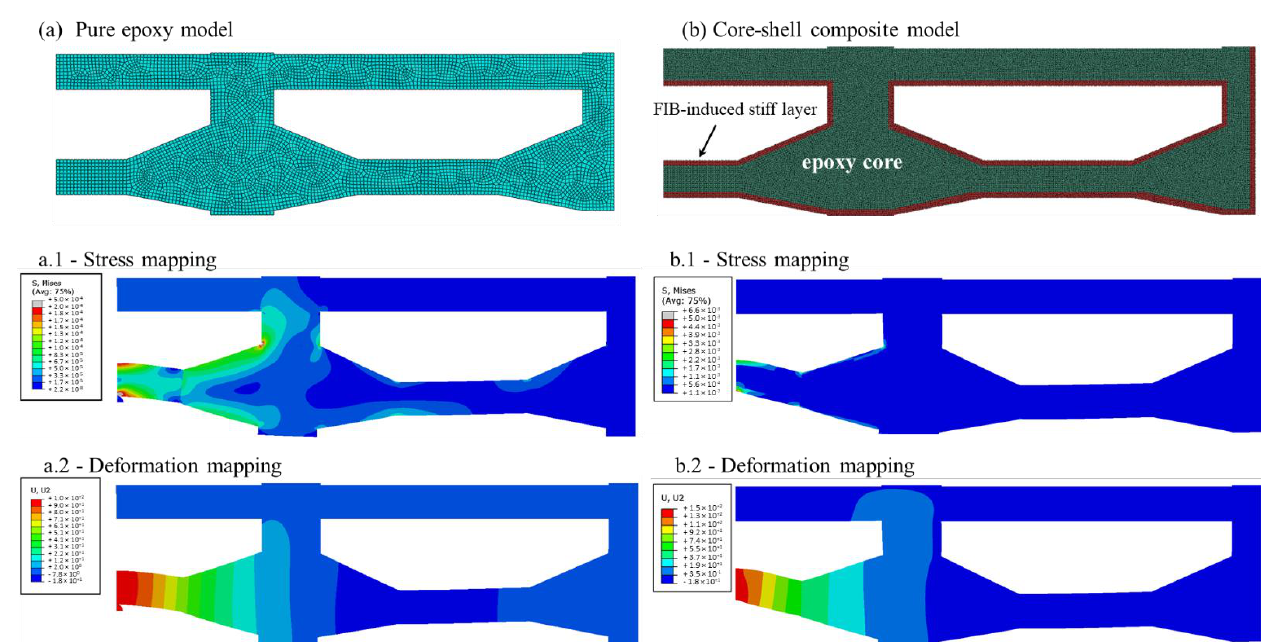
Figure 4. Finite Element Analysis of the cantilever beam during loading: the far right and top of the specimen were subjected to fixed under-boundary conditions (y and x only). The load was applied through a pin at the far bottom left of the model. ( a ) Pure epoxy model. ( a.1 ) Stress contour plot and ( a.2 ) deformation contour plot for the epoxy; maximum deformation of 150 nm and maximum stress of 183 MPa to occur at the point opposite to the loading point. ( b ) Core-shell composite model. ( b.1 ) Stress contour plot and ( b.2 ) deformation contour plot for the core-shell composite model; maximum deformation of 150 nm and maximum stress of 2.8 GPa to occur at the point opposite to the loading point. Stresses are higher at the stiff shell of 30 nm thickness. Due to symmetry, only half of the entire 3 beam model was